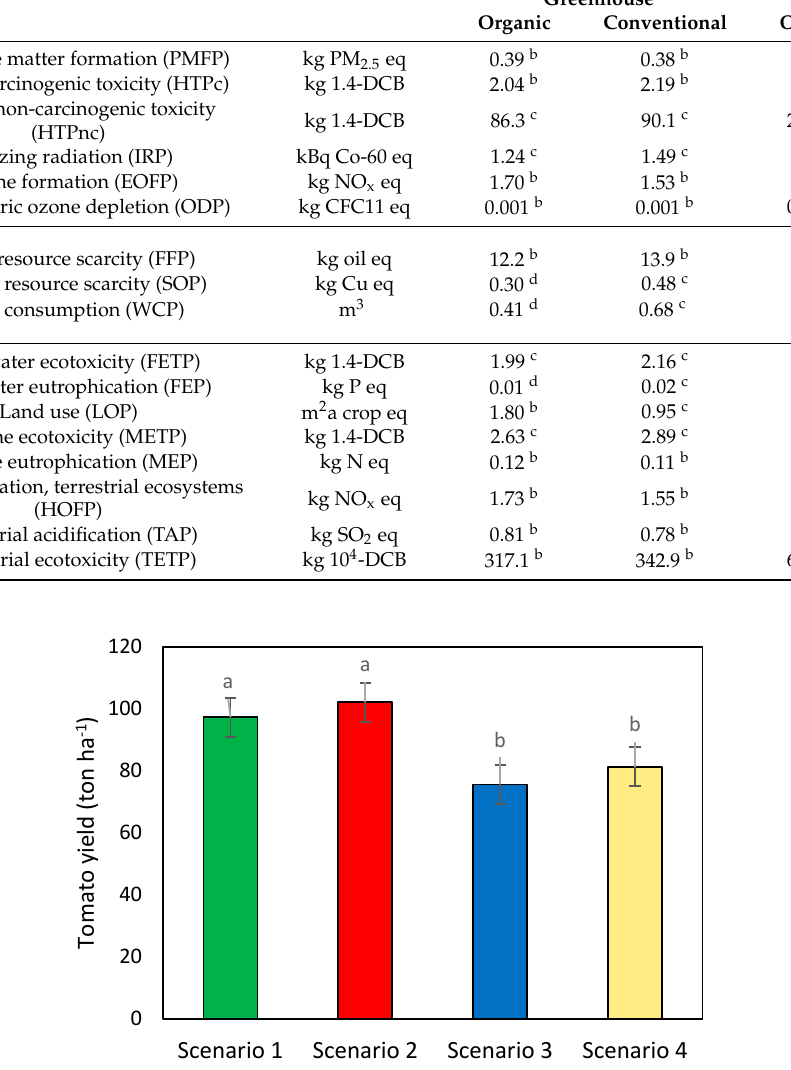
Figure 2. The tomato yield (ton ha − 1 ) in different scenarios (Scenario 1: Greenhouse—Organic, Scenario 2: Greenhouse—Conventional, Scenario 3: Open Field—Organic, Scenario 4: Open Field— Conventional). Different lower cases indicate significant differences.